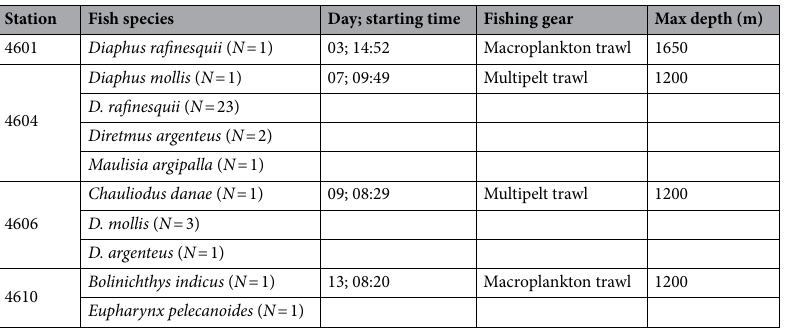
Table 1. Overview of trawl stations from which the examined fish hosts were obtained, all in May 2019. N = number of Terranova -like larvae recovered per fish species and trawl